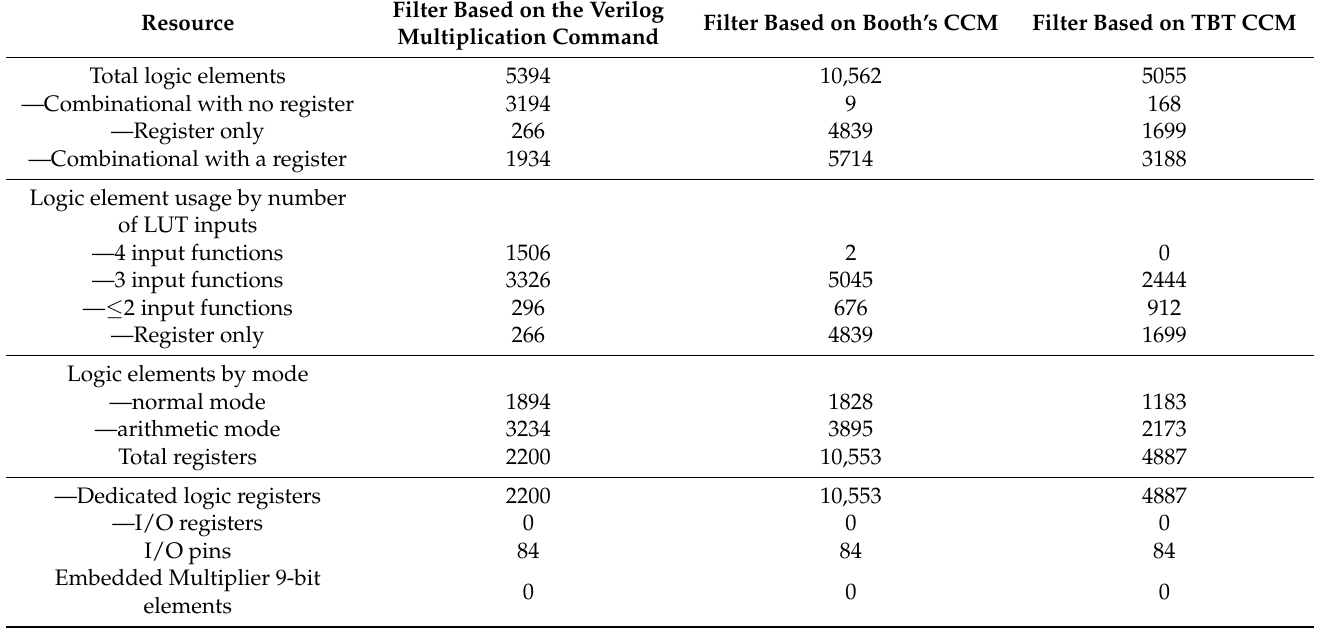
Table 10. Comparison of hardware costs of FIR filter implementations.